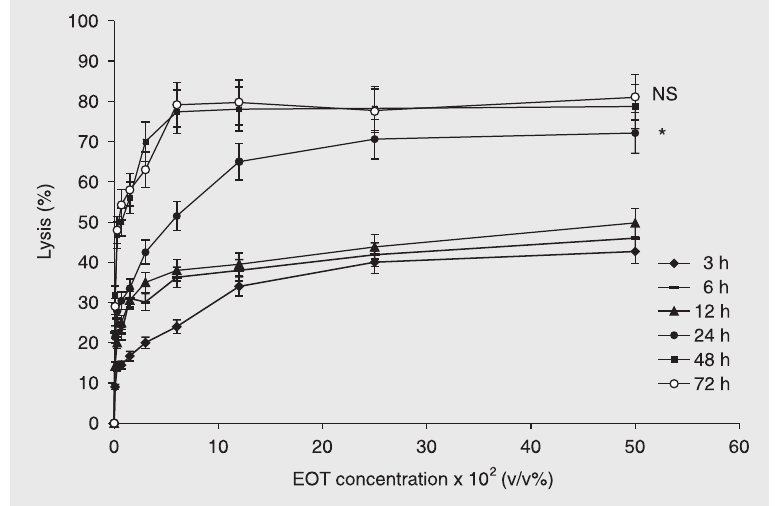
Figure 1. Kinetics of the in vitro cytotoxic activity of the essential oil of Thymus broussonettii (EOT) on the OV1/P cell line. Cells (10 5 /mL) were treated with increasing concentrations of EOT. After 3, 6, 12, 24, 48, and 72 h of incubation, cell lysis was determined as described in Material and Methods. Data are reported as the mean ± SEM of three independent